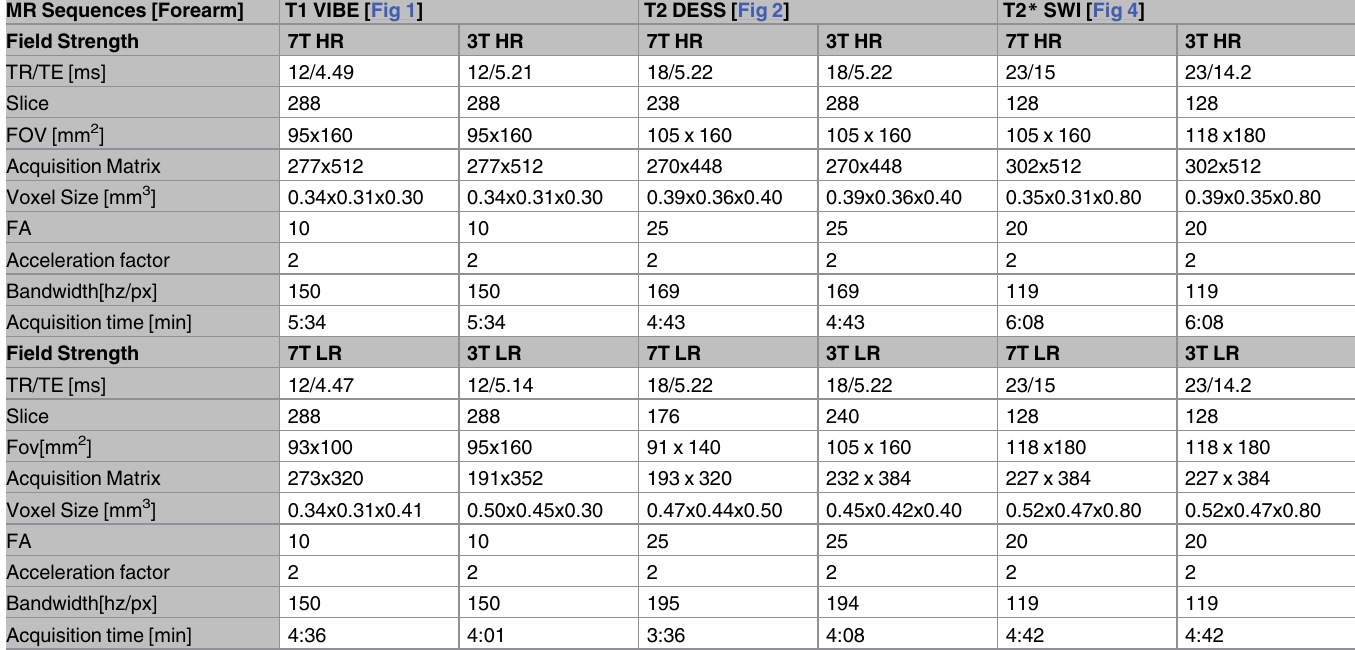
Table 1. 7T and 3T T1VIBE, T2 DESS and T2 * SWI forearm protocols for HR: Higher and LR: Lower resolution sequences. These sequencescover Figs 1, 2, 3, 4 and 6. MR Sequences [Forearm]